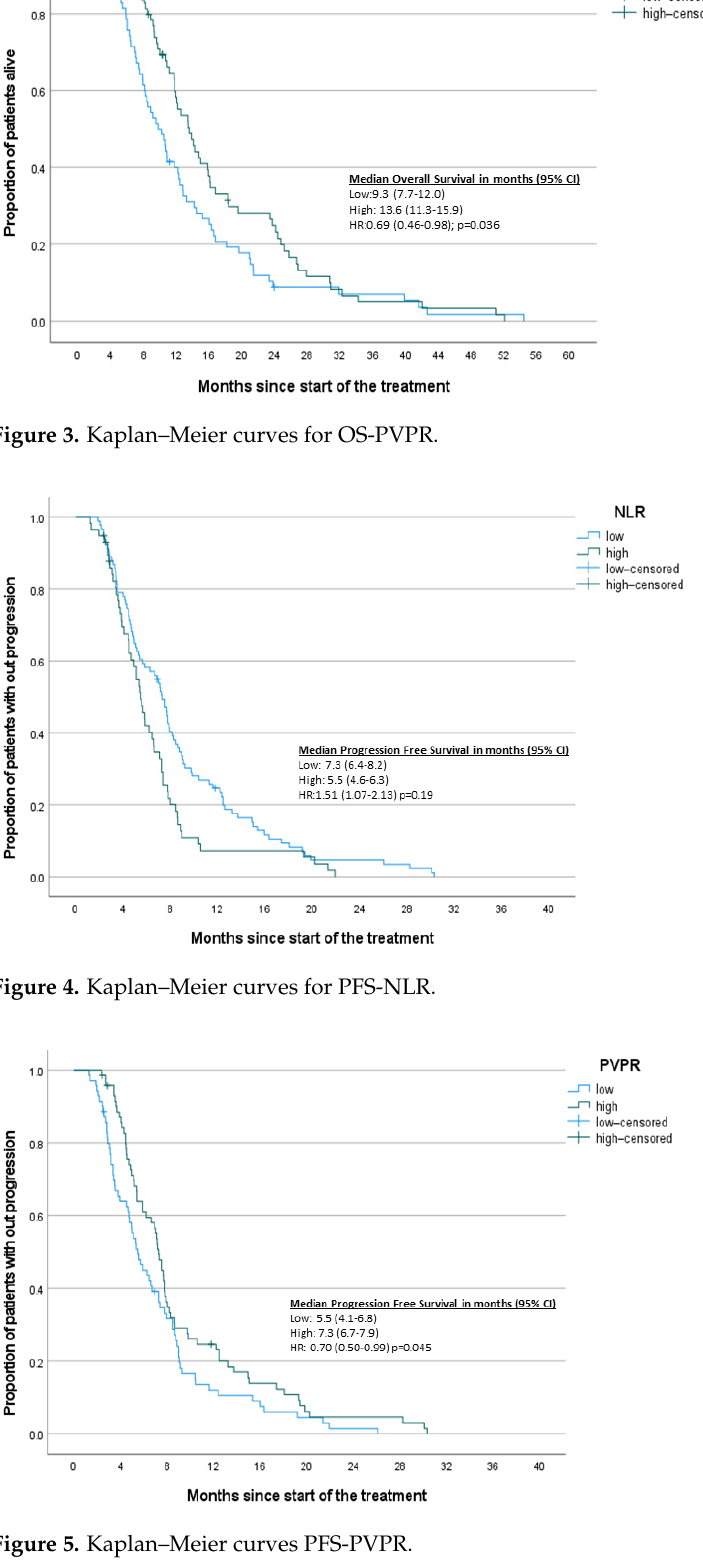
Figure 5. Kaplan–Meier curves PFS-PVPR .